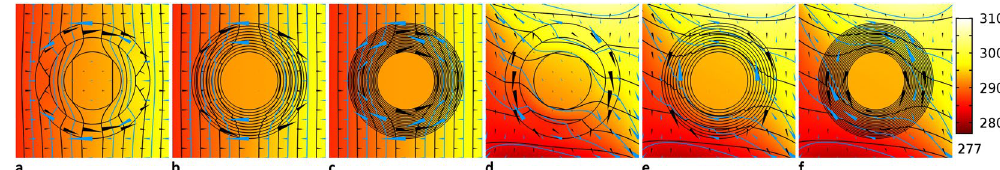
Figure 3. Layered cloaks. Simulations are shown of a N -bilayered laminate TE cloak with TE boundary conditions for ( a ) N = 1, ( b ) N = 5, ( c ) N = 10. Simulations are shown of a N -bilayered laminate TE cloak with transverse boundary conditions for ( d ) N = 1, ( e ) N = 5, ( f ) N = 10. The blue cones and curves correspond to the heat current and isotherms, respectively, while the black cones and curves correspond to the electric current and equipotentials, respectively. The background color scheme indicates the temperature